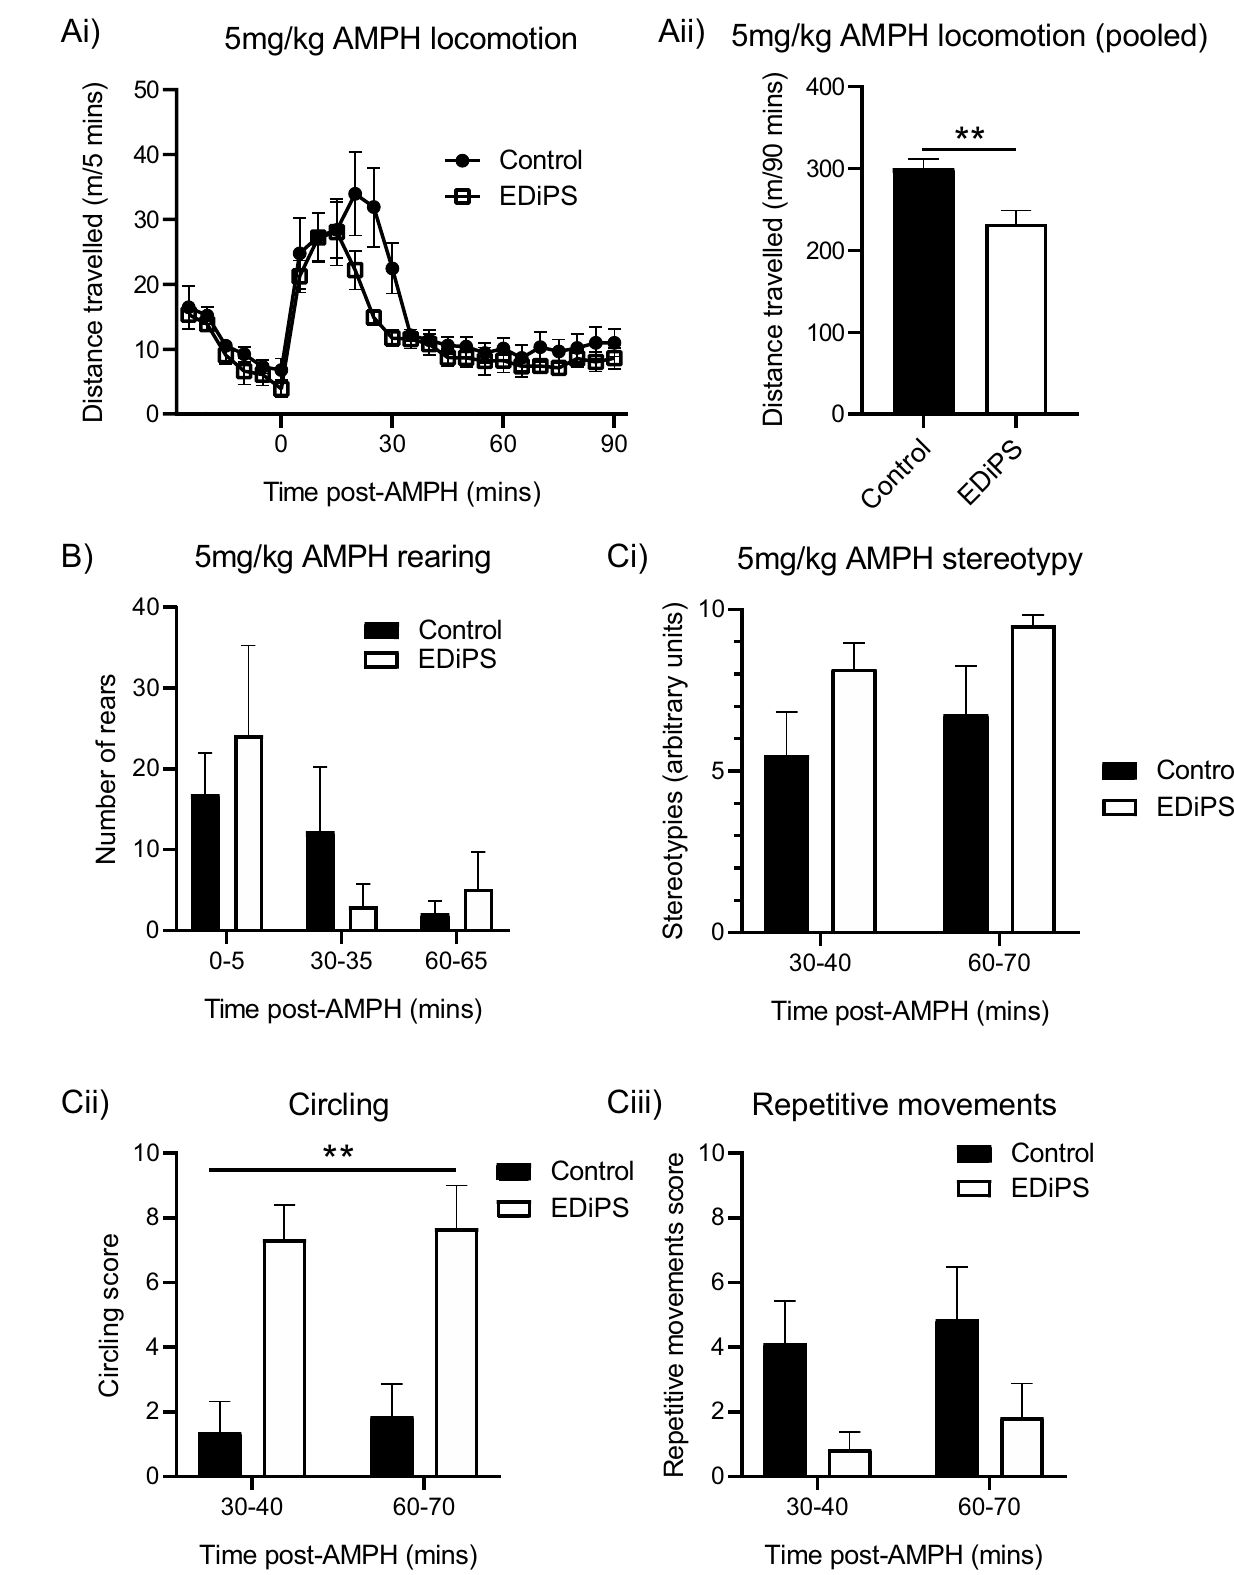
Figure 4. Behavioural responses to 5 mg/kg AMPH. ( Ai , Aii ) EDiPS animals showed significantly reduced locomotion in response to 5 mg/kg AMPH compared to control animals. ( B ) The number of rearing bouts post-AMPH was not different between EDiPS and control animals. ( Ci ) EDiPS animals did show a visible trend of increased stereotyped behaviour following 5 mg/kg AMPH, however this was not statistically significant. ( Cii ) Although overall stereotypy scores were unaltered between EDiPS and control animals, EDiPS animals displayed significantly more circling behaviour compared to control animals. ( Ciii ) The number of repetitive movements performed was statistically unchanged in EDiPS compared to control animals. AMPH Amphetamine. ** p < 0.05. ±